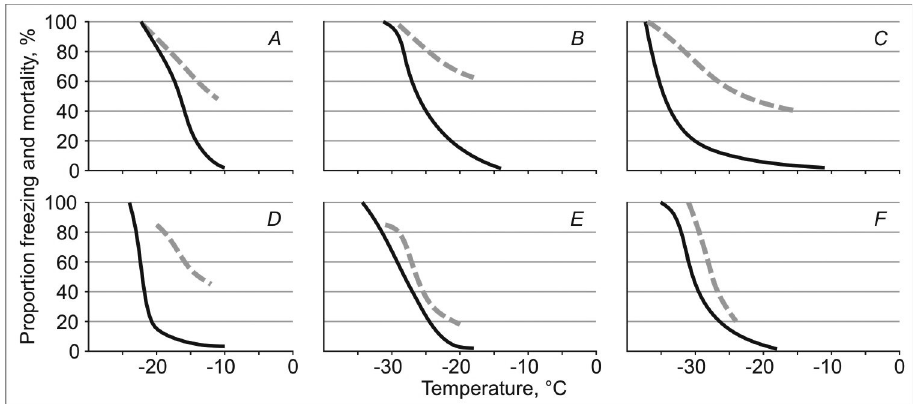
Figure 4. Cold hardiness characteristics of several ant species (plotted according to: Berman et al. 2010, Berman and Leirikh 2019). Black lines indciate SCP cumulative curves, gray dashed lines indicate cumula- tive mortality curves upon exposure to the indicated temperatures for 1 day A Formica sanquinea B Myrmica angulinodis C Camponotus herculeanus D Formica execta E Myrmica kamtschatica F Formica gagatoides